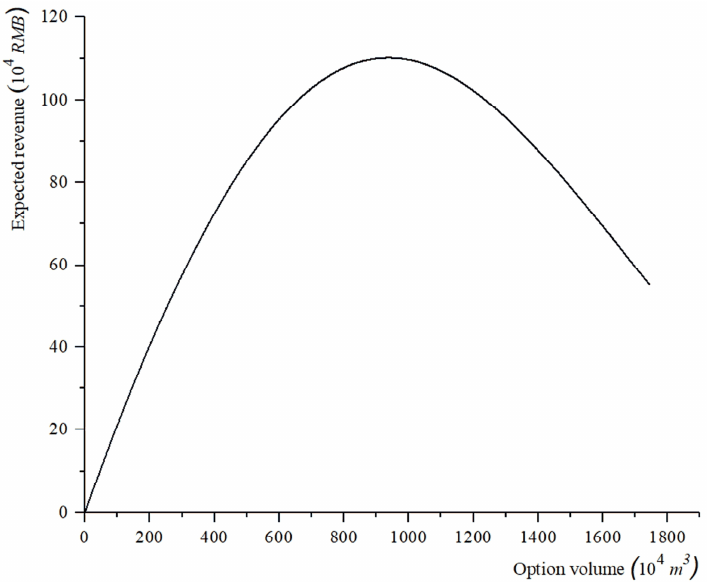
Figure 5. The relation curve between the amount of option trading and the expected revenue.